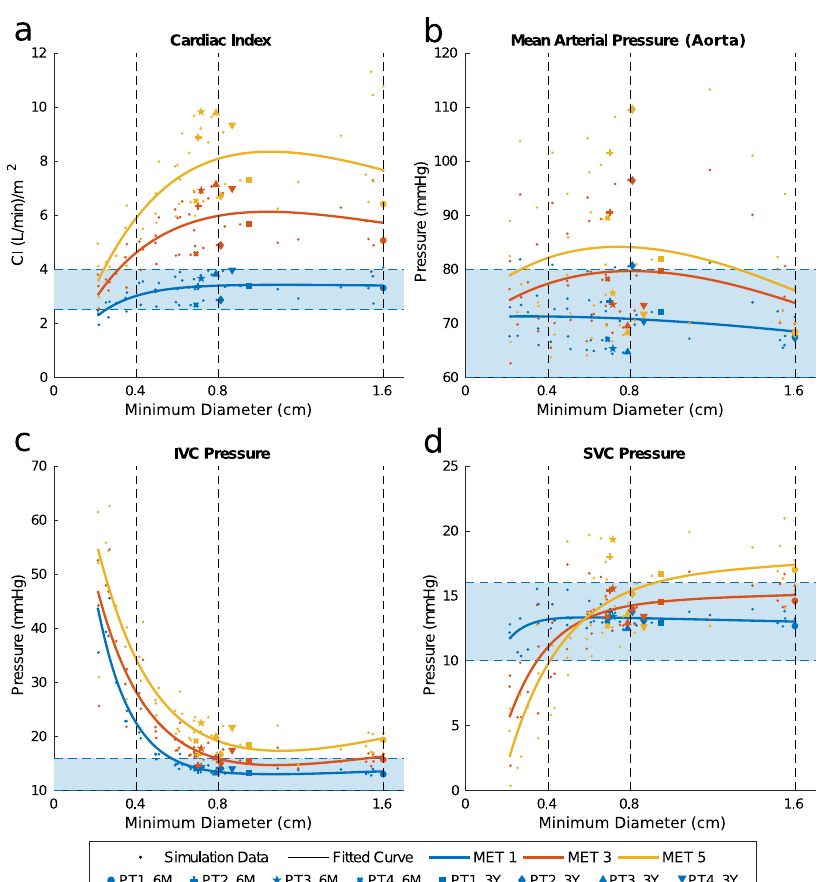
Fig. 7 Systemic and venous metrics describing the performance of simulated and MRI measured graft geometries in terms of cardiac index (CI), arterial pressures, and venous pressures. a Estimated CI at MET levels with a MET 1 reference values of 2.5 – 4.0 L/min/m 2 indicated by the shaded region. b IVC pressures at MET levels with a MET 1 reference values of 10 – 16 mmHg indicated by the shaded region. c MAPs at MET levels with a MET 1 reference values of 60 – 80 mmHg indicated by the shaded region. d SVC pressures at MET levels with a MET 1 reference values of 10 – 16 mmHg indicated by the shaded